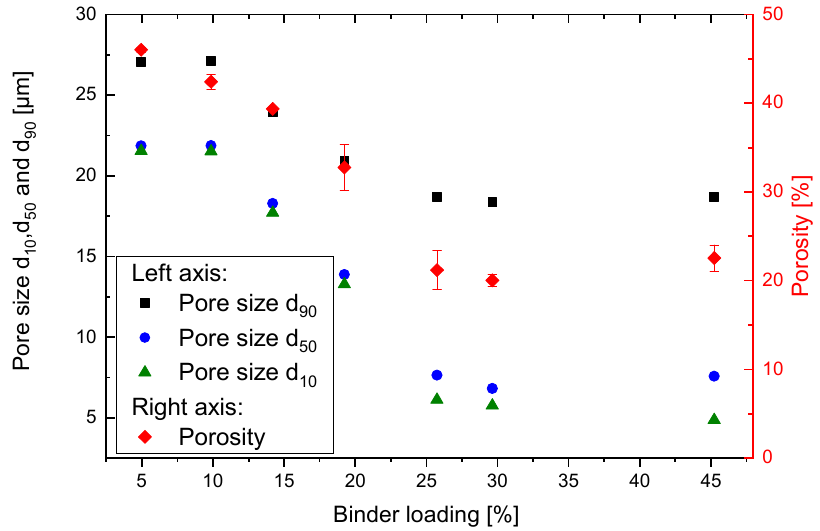
Figure 9. Porosity and pore size d90, d50, and d10 at different binder loadings. The pore sizes and porosity follow a similar trend. After a decrease between 20% and 25% BL, the values reach a constant level.